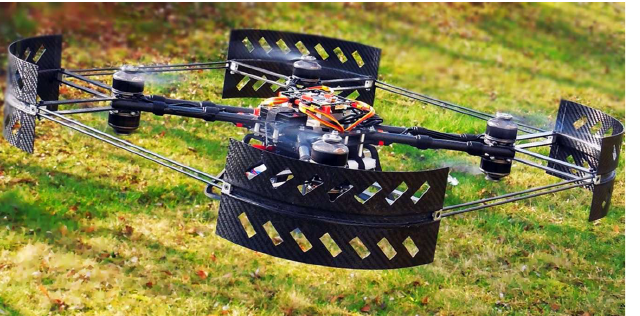
Figure 1. The Falcon V5 coaxial quadrotor developed at the Institute of Robotics and Machine Intelligence of Poznan University of Technology.